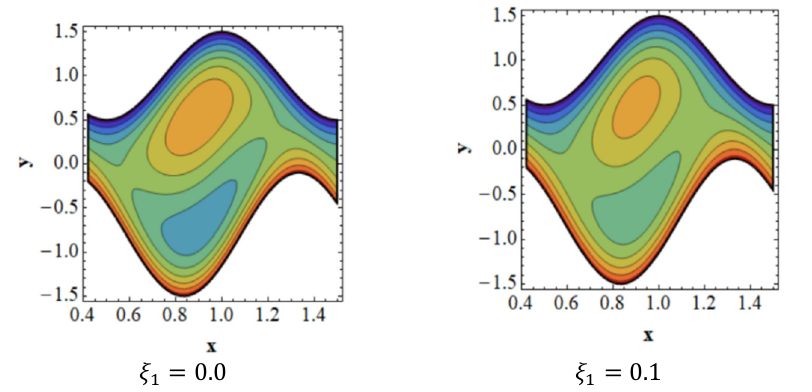
Figure 8. Consistency of streamlines for values of ξ 1